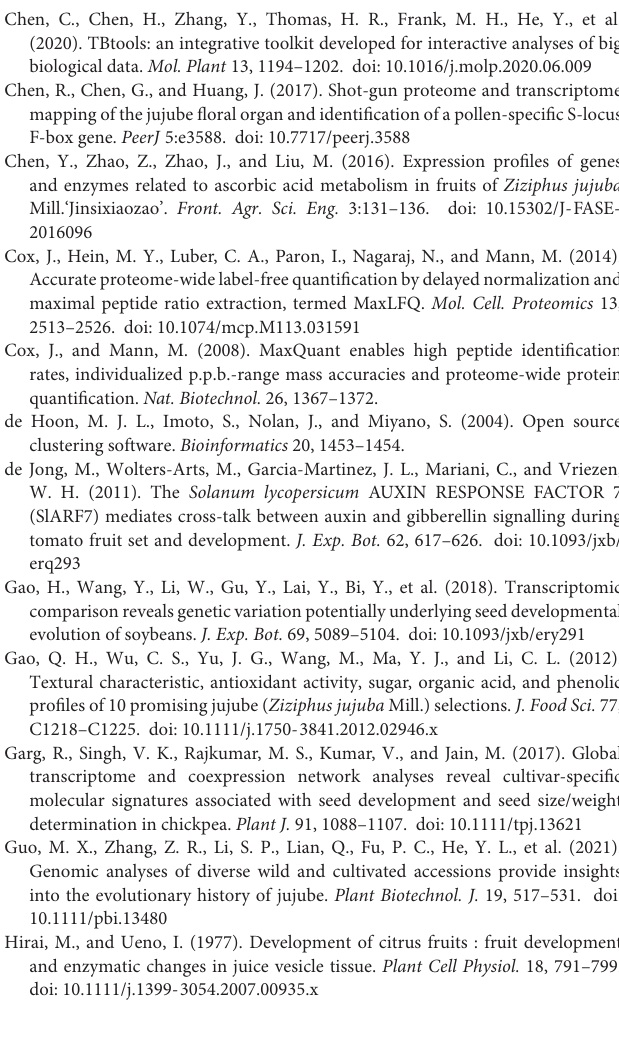
network analysis (WGCNA).